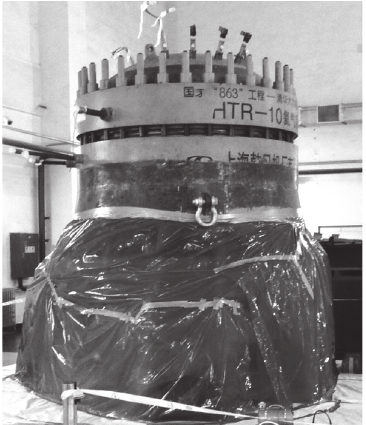
Figure 4: The removed helium circulator wrapped with the gas insulation